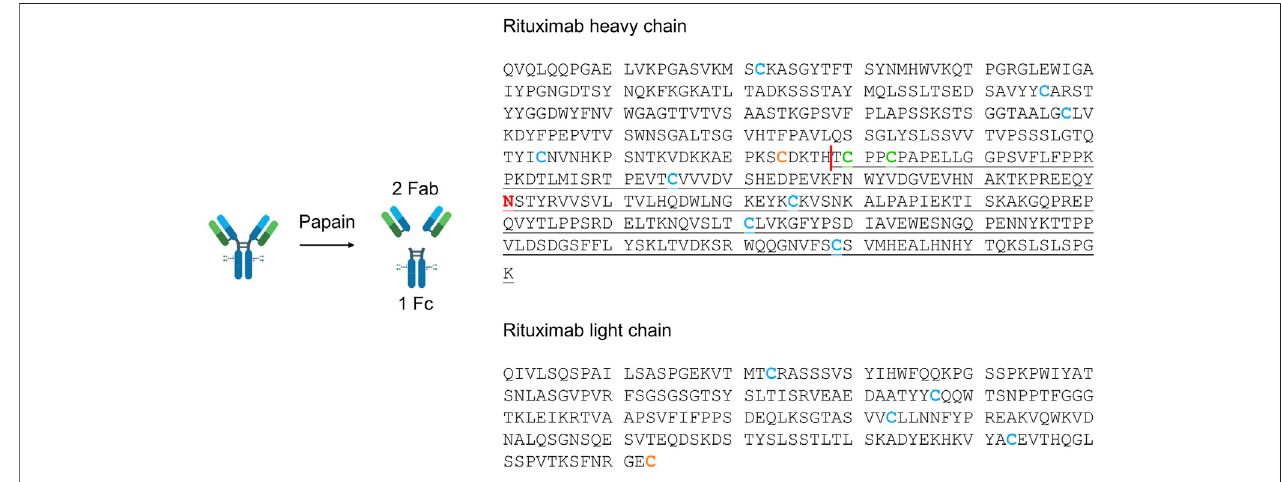
FIGURE4| Aminoacidsequenceofrituximabheavyandlightchains.Thepapaincleavagesiteisshownasaredverticalline.TheFabfragmentiscomposedofthe non-underlined amino acids of the heavy and light chains, while Fc residues are underlined. The glycosylation site is represented by the red asparagine in the Fc region. Cysteines included in intrachain (blue) and interchain (orange between light and heavy chains, green between two heavy chains) disul fi de bonds are highlighted. The reaction scheme was created with BioRender.com.